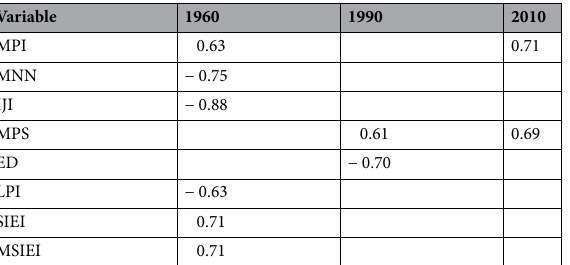
Table 3. Pair-wise Spearman rank correlations between the average level of vulnerability to land degradation (regional ESAI, see Table 2) and landscape metrics (see Table 1 for acronyms) at the same spatial scale (only significant coefficients at p < 0.05 were shown after Bonferroni’s correction for multiple